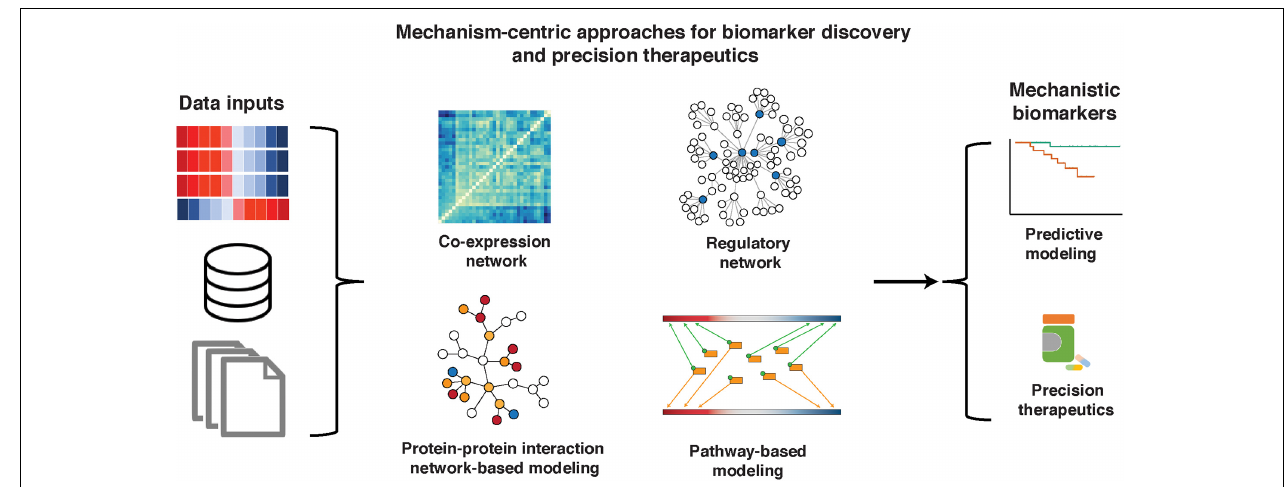
FIGURE 1 | Mechanism-centric approaches in biomarker discovery and precision therapeutics. A variety of data, including single- and multi-omic sources, knowledge bases, and phenotype/clinical information, can be used as inputs to mechanism-centric approaches to identify functional biomarkers of disease and therapeutic response. We describe mechanism-centric methods that are based on co-expression networks, regulatory networks, PPI networks, and molecular